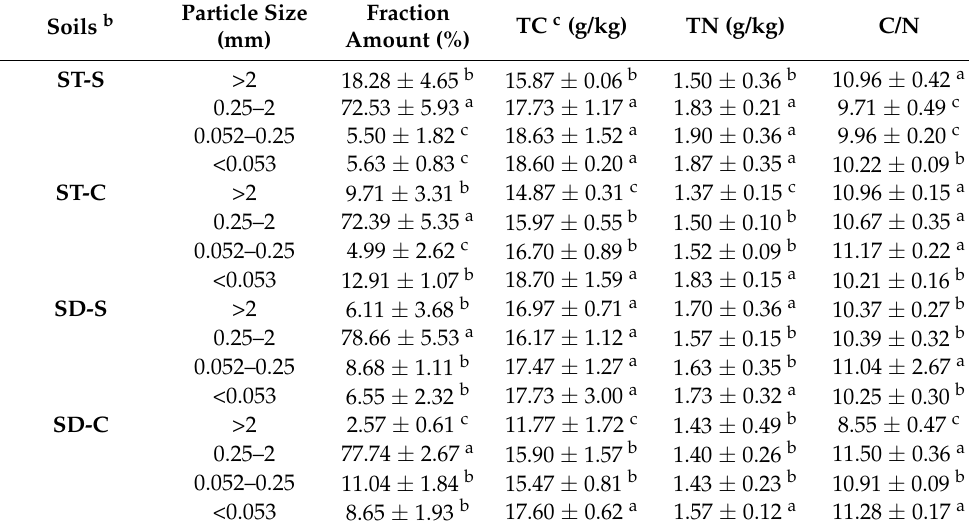
Table 1. The characteristics of different soil fractions a